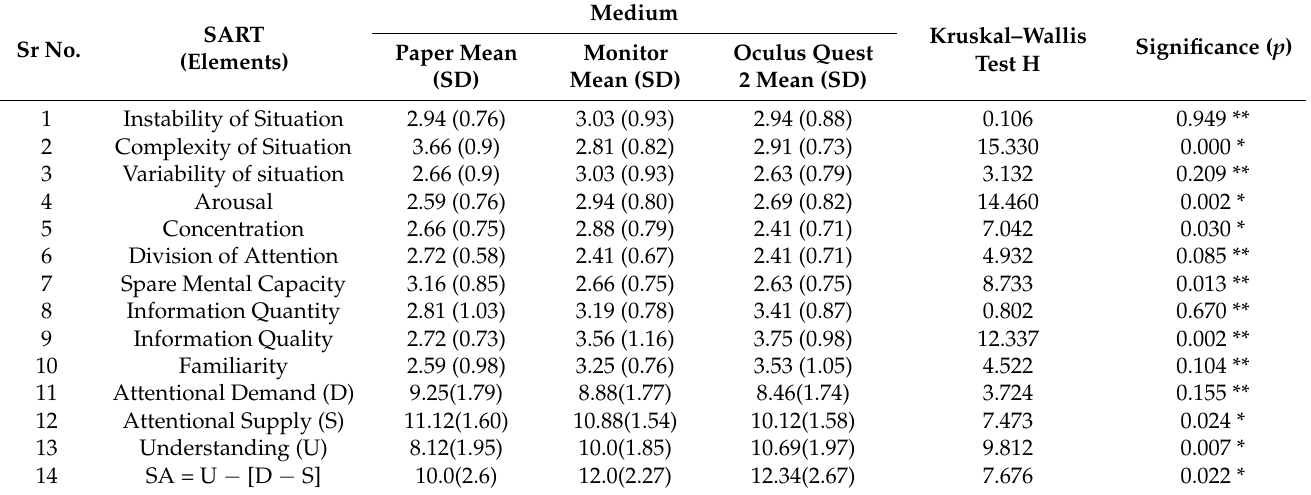
Table 5. Situational awareness rating technique descriptive statistics and Kruskal–Wallis test